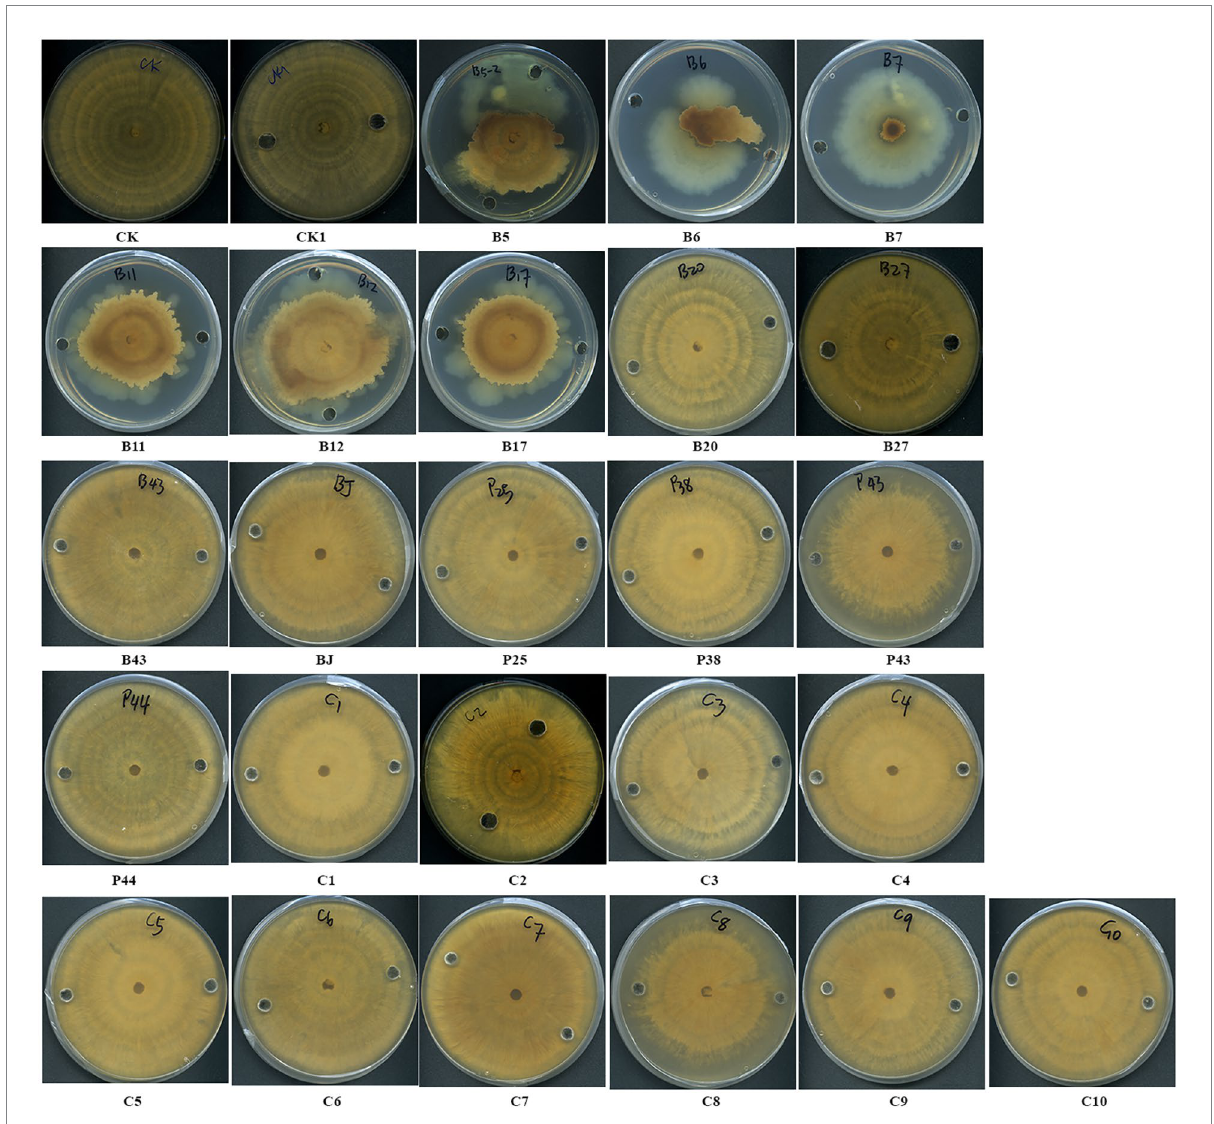
FIGURE 5 Effects of cell-free supernatants (CFSs) of bacteria on the growth of R. solani AG8. CK: AG8 only; CK1: ddH 2 O; B5: CFSs of Pseudomonas sp. B5; B6: CFSs of Streptomyces sp. B6; B7: CFSs of Chryseobacterium sp. B7; B11: CFSs of Pseudomonas sp. B11; B12: CFSs of Pseudomonas sp. B12; B17: CFSs of Sphingomonas sp. B17; B20: CFSs of Cupriavidus campinensis B20; B27: CFSs of Asticcacaulis sp. B27; B43: CFSs of Rhodococcus erythropolis B43; BJ: CFSs of Janthinobacterium lividum BJ; P25: CFSs of Pseudomonas sp. P25; P38: CFSs of Chryseobacterium soldanellicola P38; P43: CFSs of Chryseobacterium sp. P43; P44: CFSs of Pedobacter sp. P44; C1: CFSs of SynCom 1; C2: CFSs of SynCom 2; C3: CFSs of SynCom 3; C4: CFSs of SynCom 4; C5: CFSs of SynCom 5; C6: CFSs of SynCom 6; C7: CFSs of SynCom 7; C8: CFSs of SynCom 8; C9: CFSs of SynCom 9; C10: CFSs of SynCom